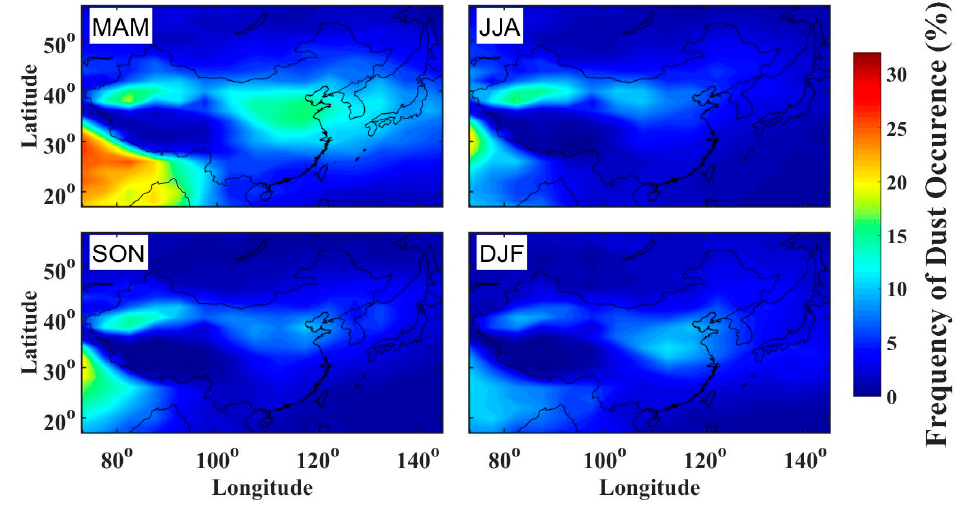
Figure 2. The seasonal variations in the frequency of dust occurrence over East Asia based on Cloud-Aerosol Lidar and Infrared Pathfinder Satellite Observations (CALIPSO) data.